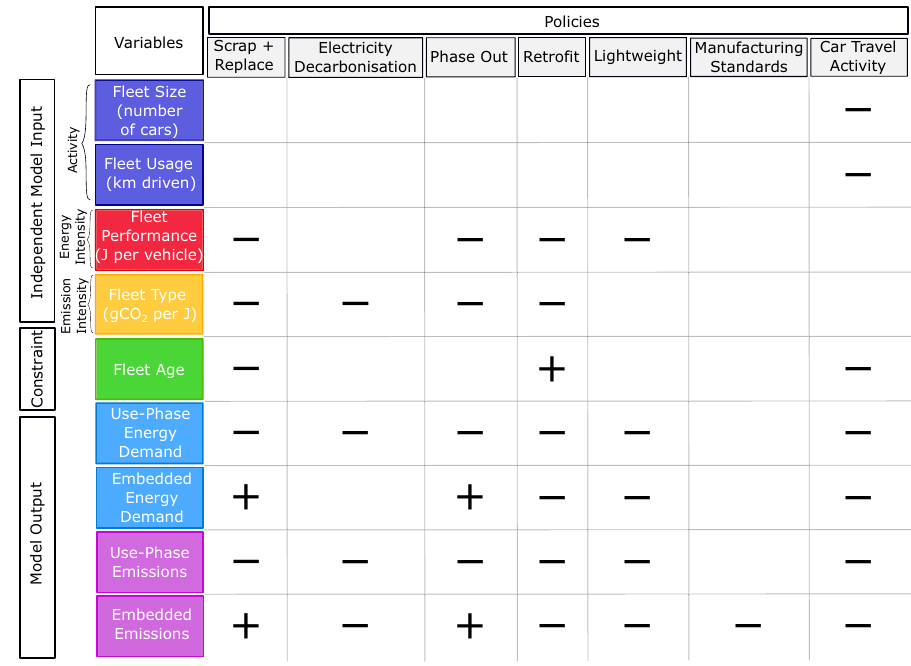
Fig. 2 | Effects of different policies within the UTPM. The policies can either increase(plus-sign)ordecrease (minus-sign)themagnitudeofvariables,whichare divided into inputs, constraints and outputs for the model. Fleet size refers to the level of activity of the fl eet (sizeand usage), fl eetperformancerefers to the energy ef fi ciency per vehicle (or alternatively per km driven) and fl eet type refers to the emissionsintensityperJoulespentinthevehicle(whichisdependentonthetypeof